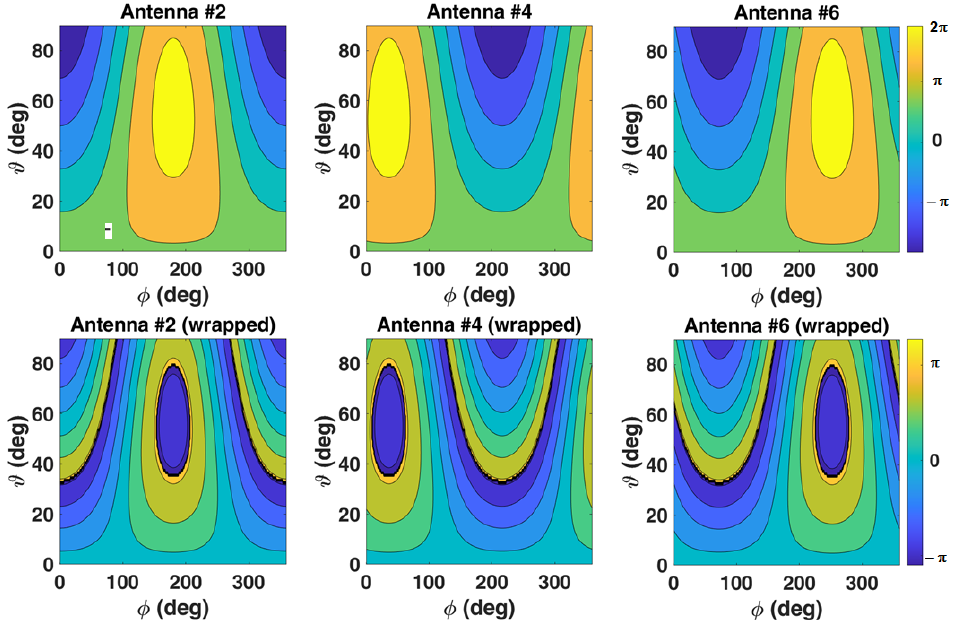
Figure 8. Ideal and wrapped phase differences respect to reference antenna #1.